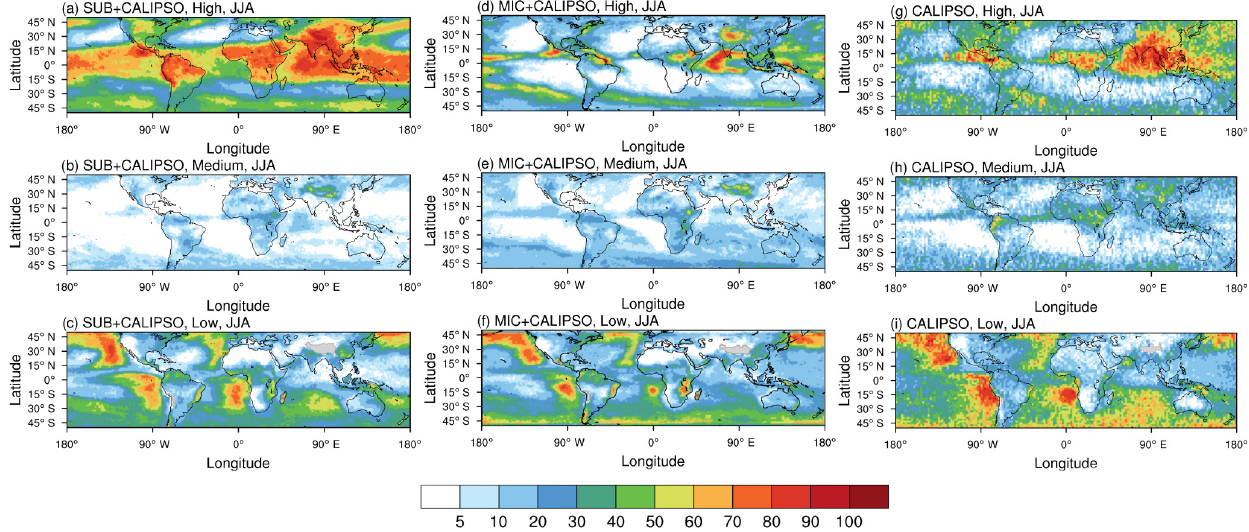
Figure 4. Left panels show RegCM4’s high, middle, and low clouds (from top to bottom) using SUB and the CALIPSO simulator for during JJA 2007 (unit in %). Middle panels show the same fields using MIC and right panels show CALIPSO observations. Table 3. Global means of high, medium, and low clouds of SUB and MIC vs. observations.